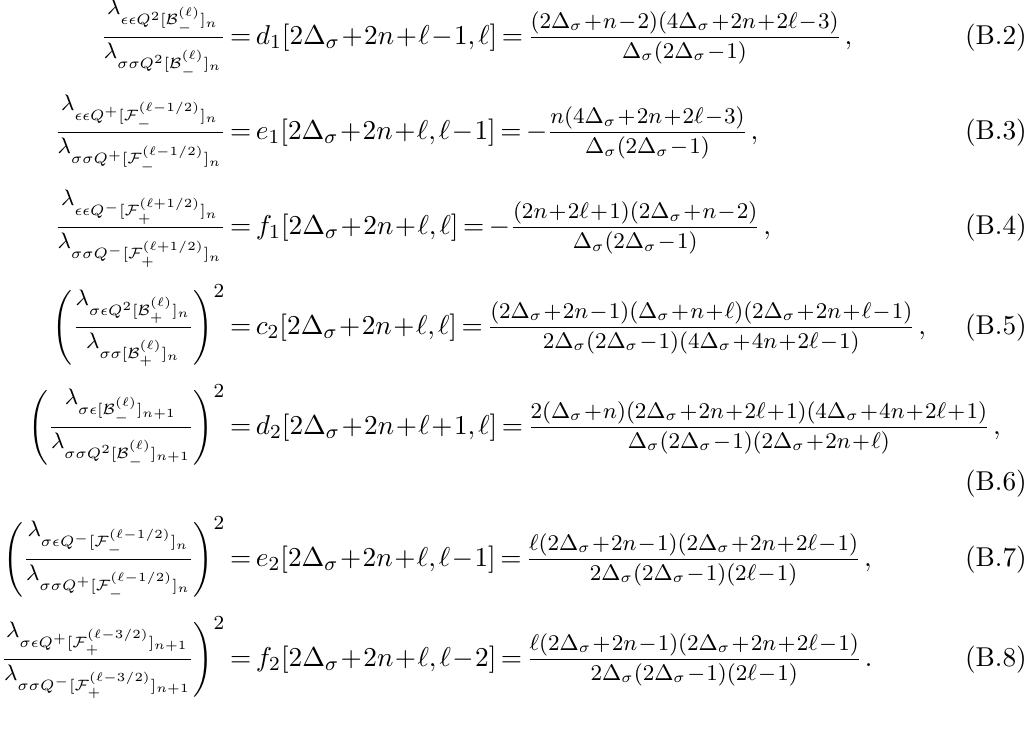
Table 4 . Parameters used for the navigator computations. The sets S Λ are defined in (A.2). λ (cid:15)(cid:15)Q 2 [ B ( ‘ ) − ]